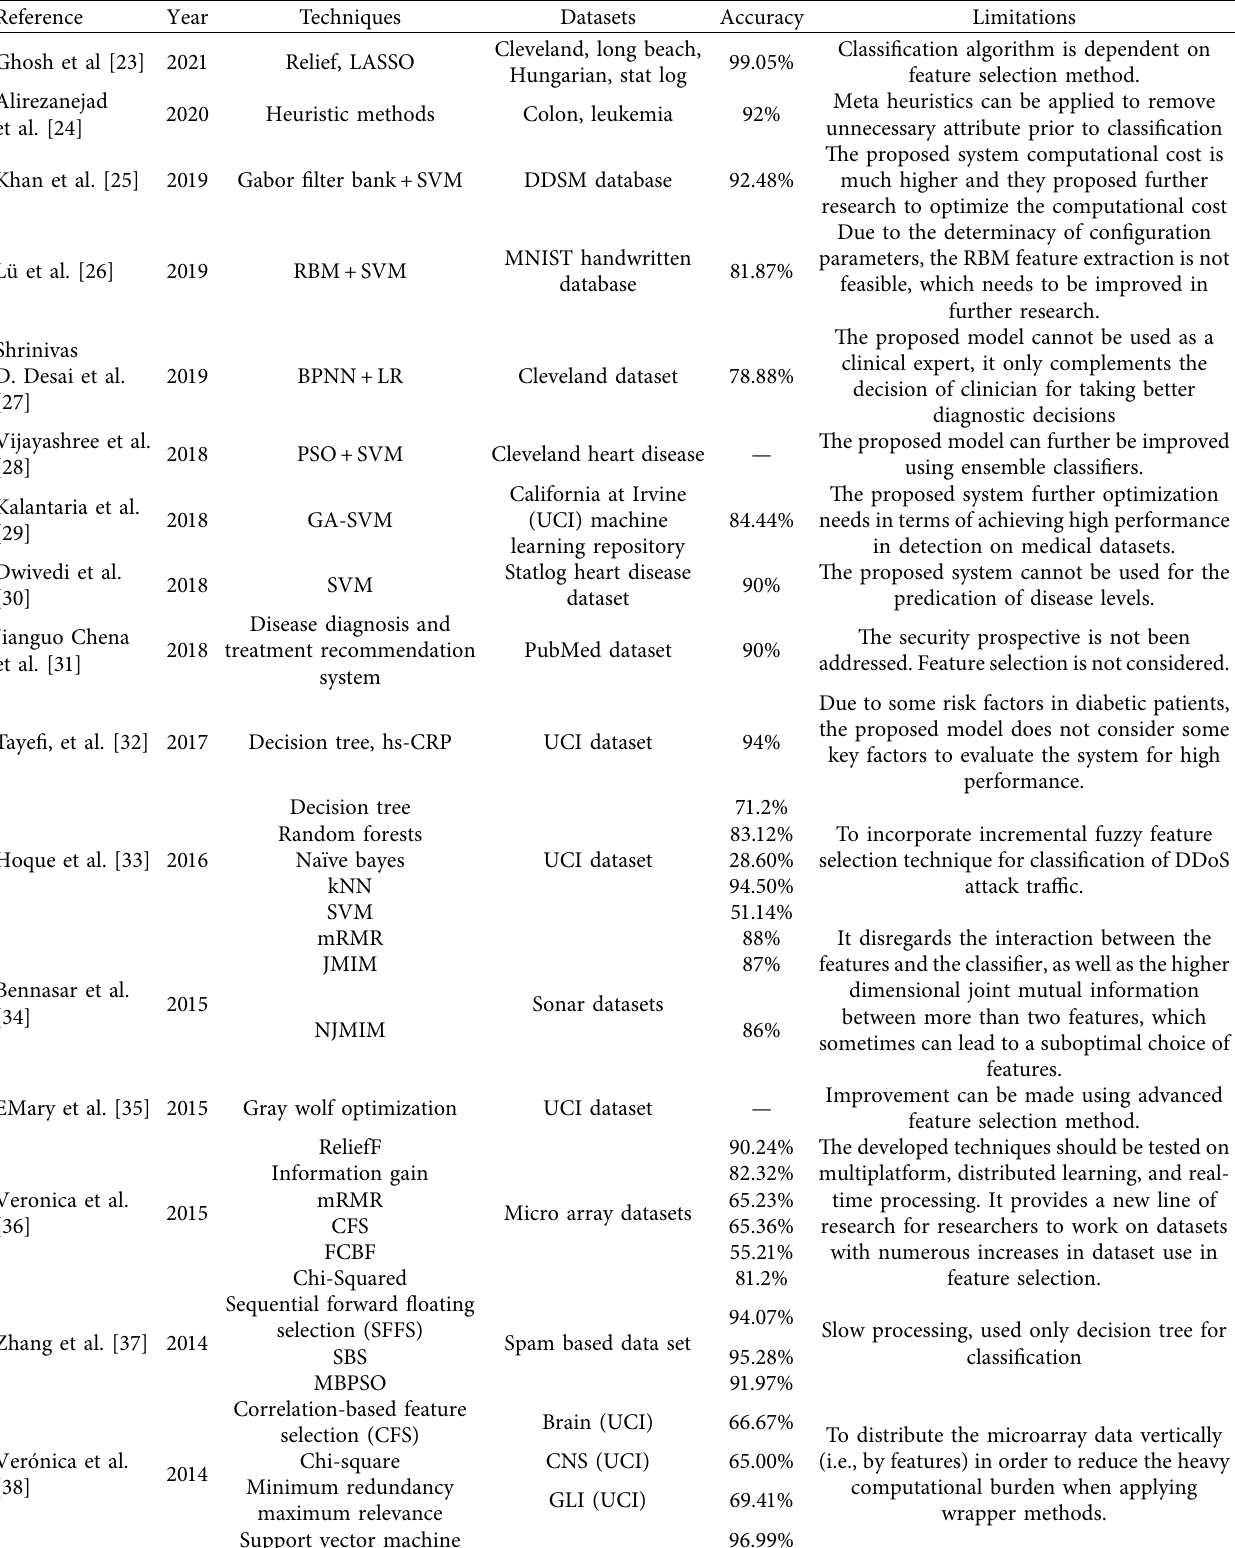
Table 1: Summary of data mining algorithms using feature selection on medical